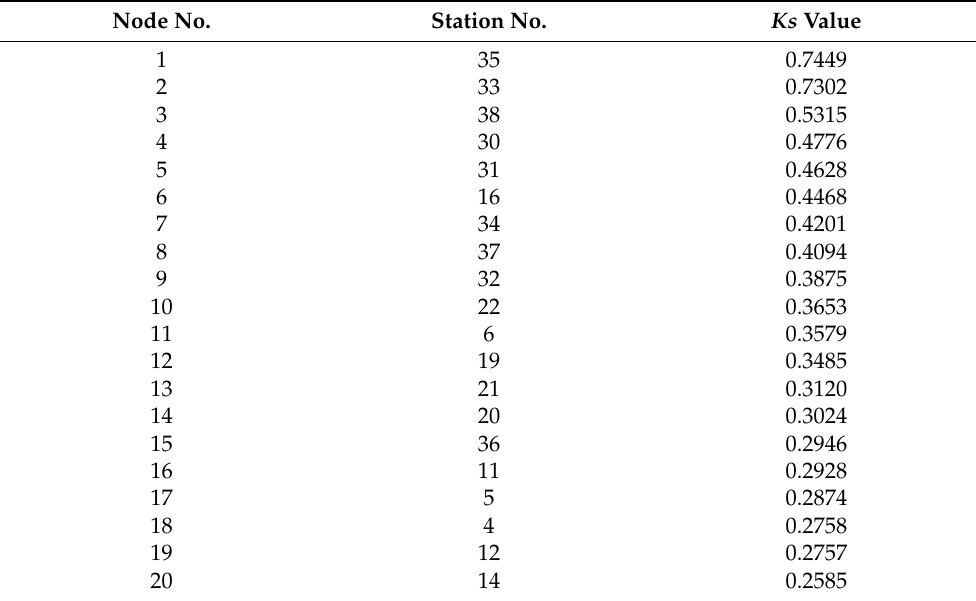
Table 2. Node Ks Value